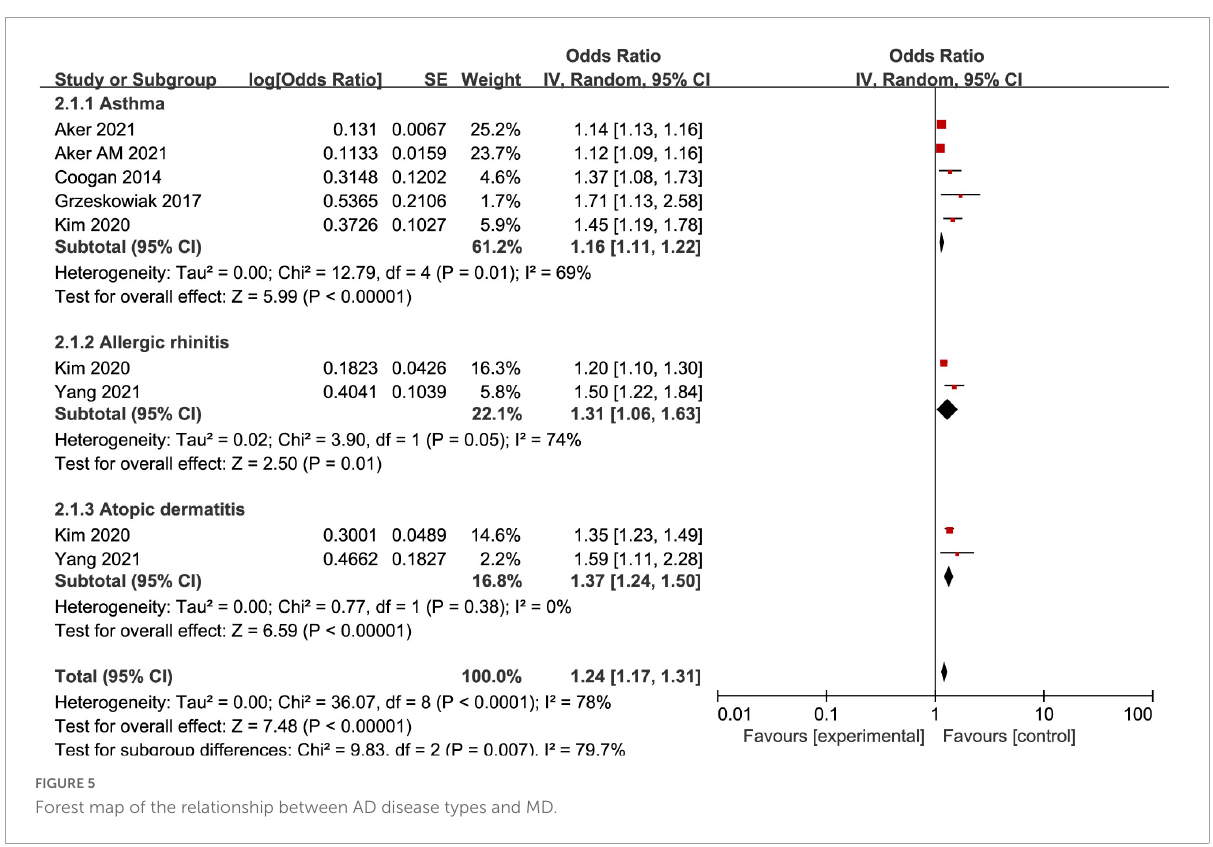
TABLE 4 Meta-analytical results and results of the subgroup analyses on the association between allergic diseases and mental